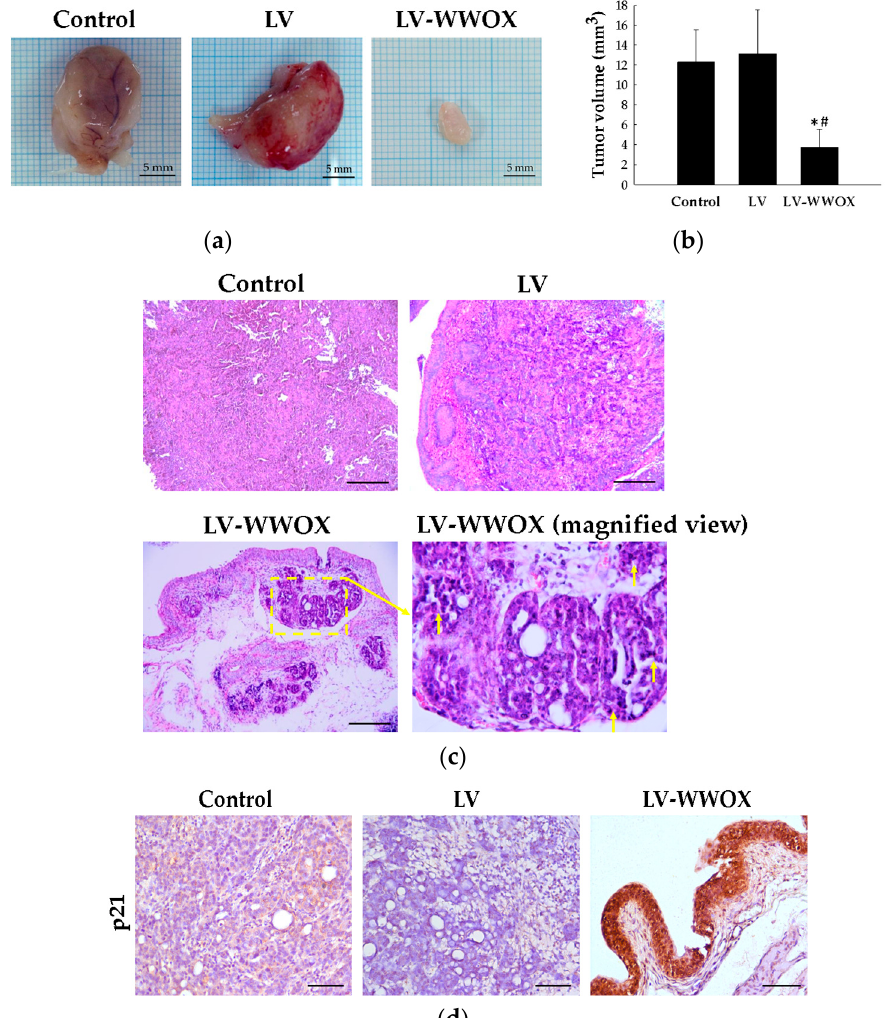
Figure 5. Inhibitory effects of WWOX in the F344/AY-27 rat model. ( a ) Excised tumor photographs. ( b ) Tumor volume (tumor volume = (longer diameter × shorter diameter 2 )/2) was analyzed. The